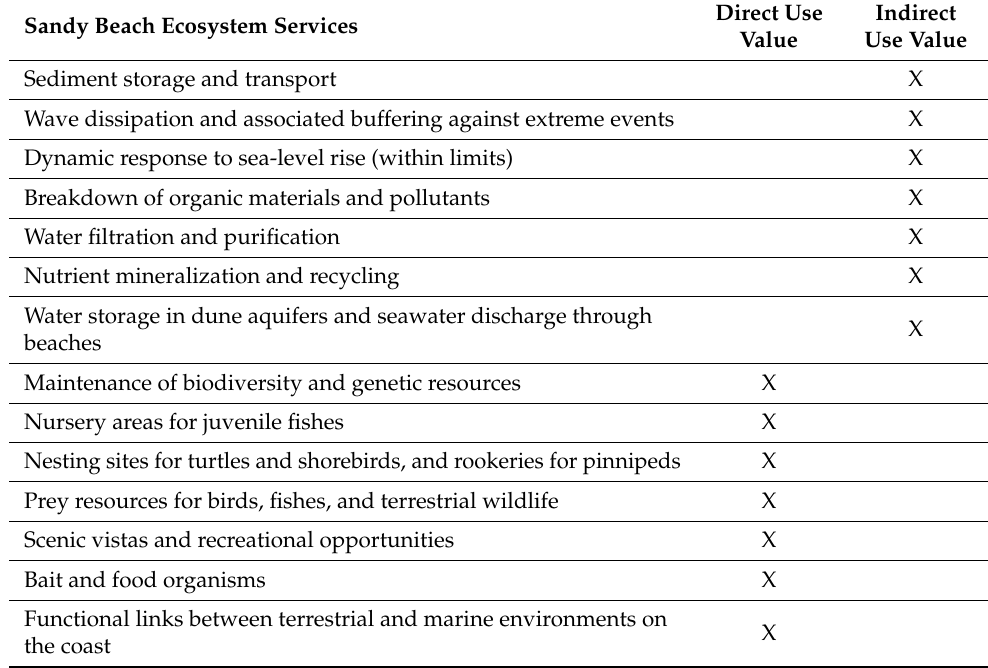
Table 2. Sandy Beach Ecosystems Services by Use Value Type